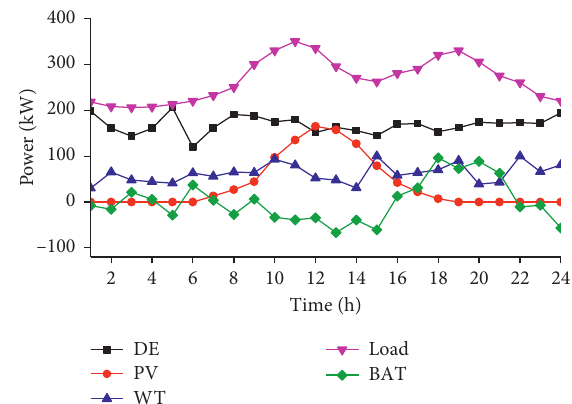
Figure 11: Output power of generation units for scheme